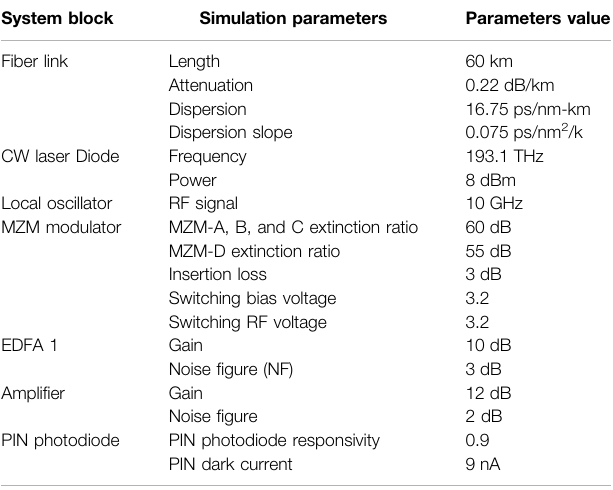
TABLE 2 | Simulation parameters employed for the present scheme of frequency 16 MM wave signal generation.